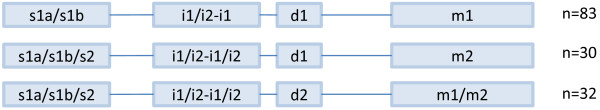
Summary of the vacA gene mosaic combinations based on amplicon sequencing in 145 biopsies. Genotypes in the remaining 14 biopsies could not be established. N = number of strains; s1/s2, signal-sequence type; i1/i2 = intermediate region type; d1/d2 = deletion type; m1/m2 = mid-region type.